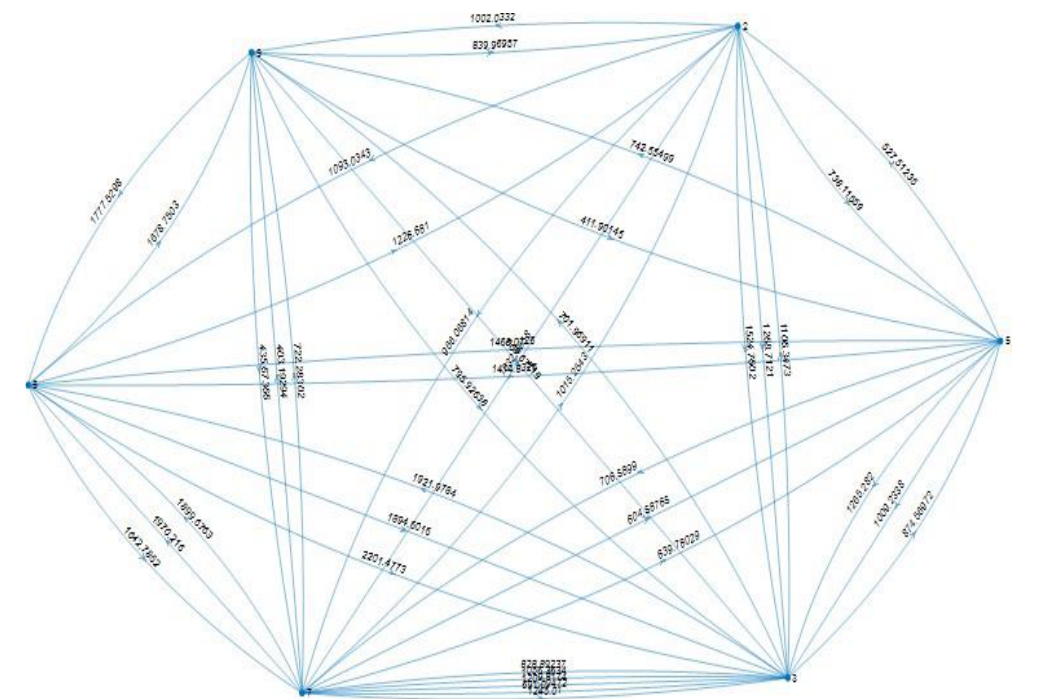
Figure 17. Abstract representation of Linden network.